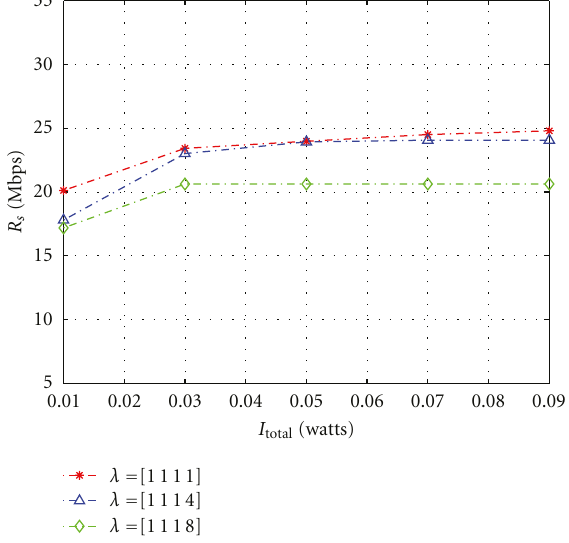
Figure 6: Average total CRU bit rate, R s , versus maximum PU tolerable interference power, I total , with P total = 25 W, P m = 5 W, and ρ = 0 . 9.